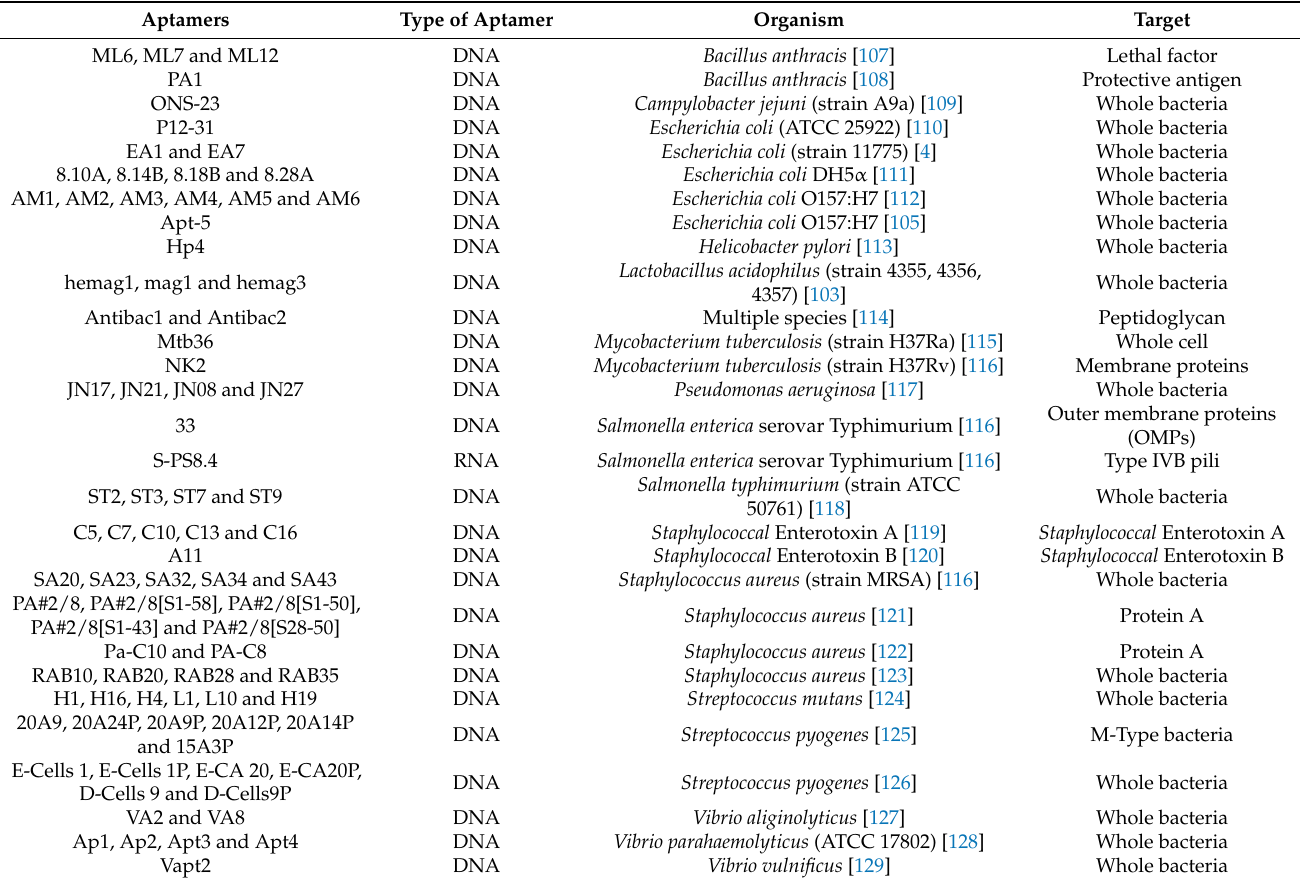
Table 3. Aptamers currently generated against bacteria.